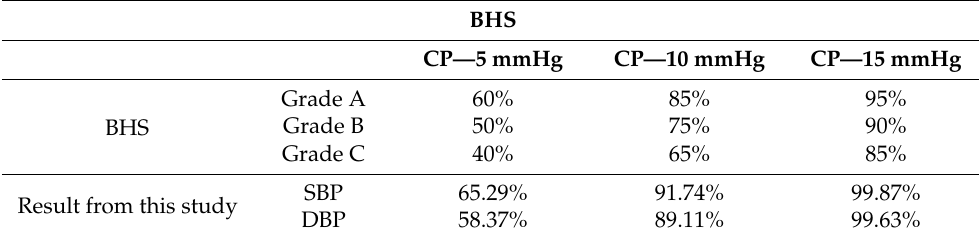
Table 4. Proposed method’s performance according to